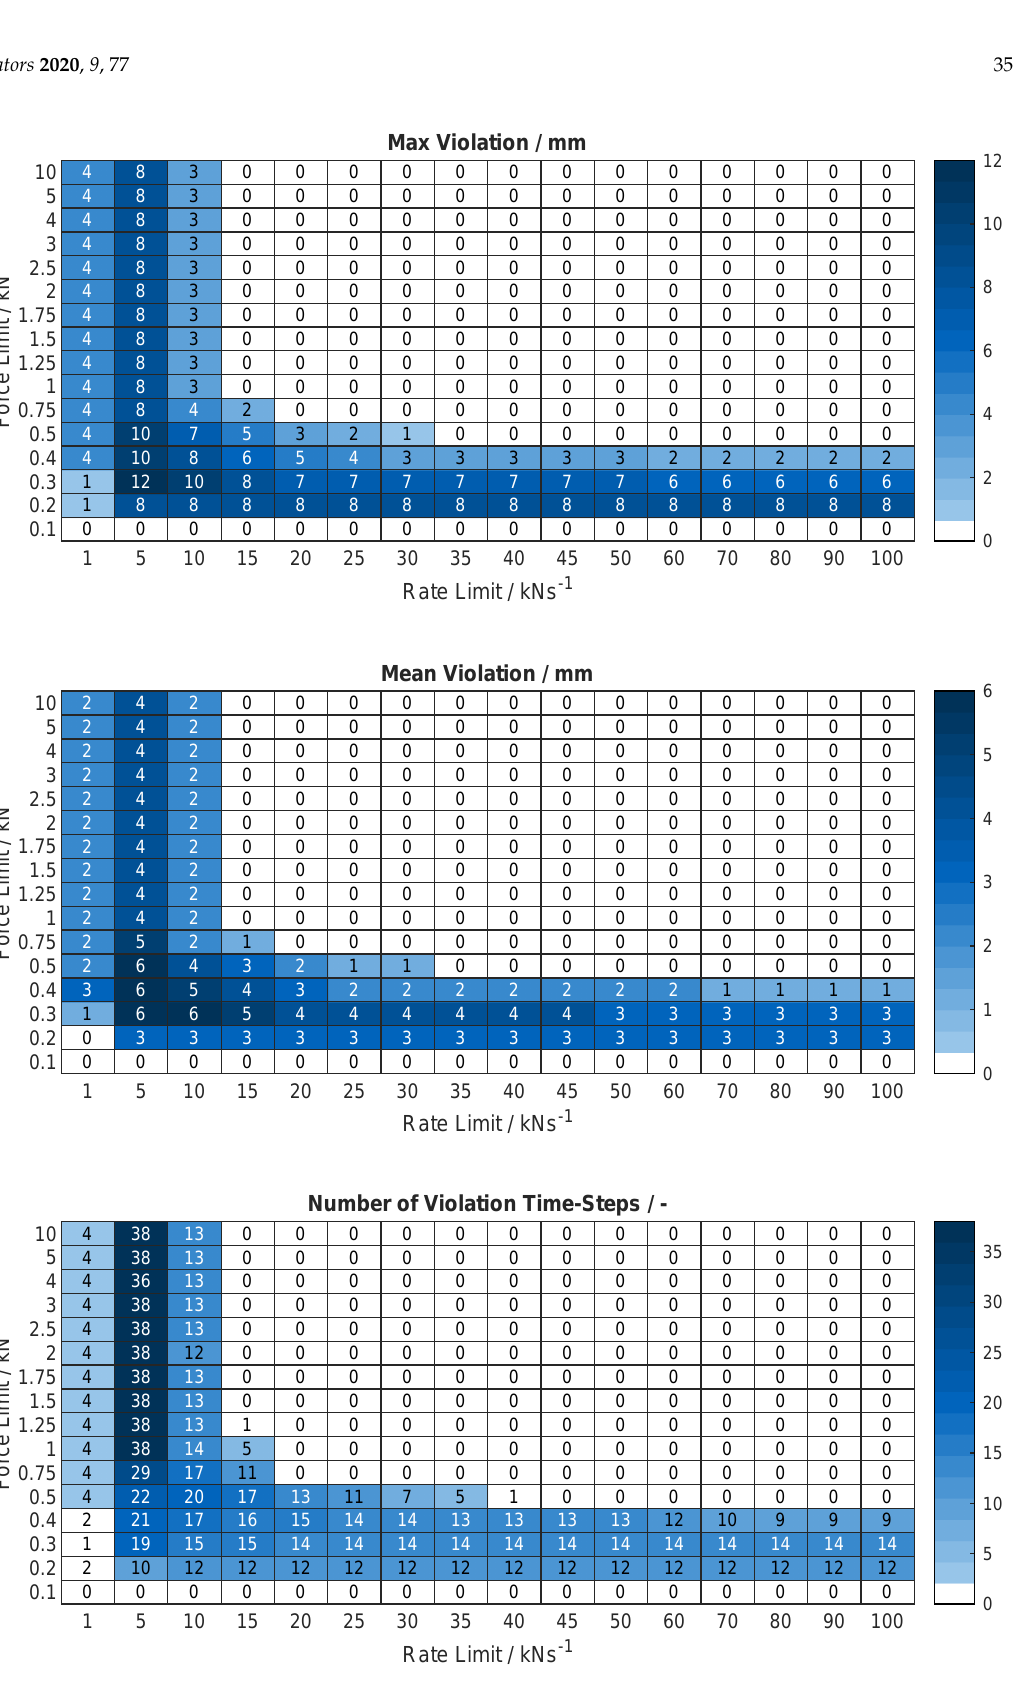
Figure A20. Suspension-deflection constraint violations in the 90kmh − 1 BC profile dynamic wheel-load optimization